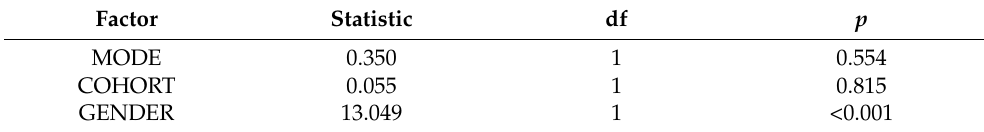
Figure 2. A scatterplot of PRSs of 202 pupils (group ALL) by MODE (PBA and CBA) and by COHORT (Y09 and Y10). A Kruskal–Wallis test ran on the variables of group ALL (N = 202) only reported a main statistical effect of GENDER on the pupil’s PRSs (chi-squared = 13.05, df = 1, p -value < 0.001). This means that the PRSs of females are significantly higher than the PRSs of males. The other factors (MODE and COHORT) had not a statistical impact (Table 7). Table 7. Kruskal–Wallis Test.